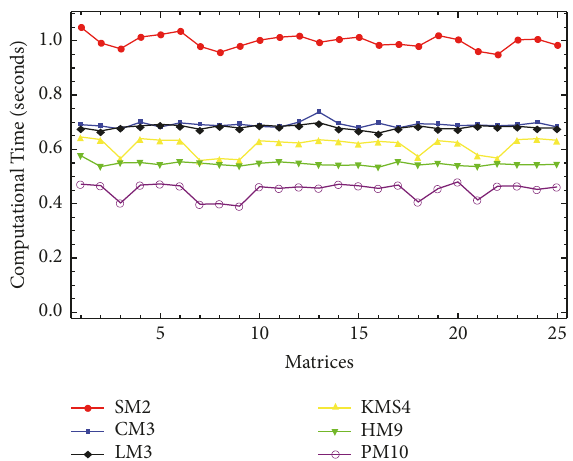
Figure 1: Comparison of the elapsed times for various methods in Experiment 2.